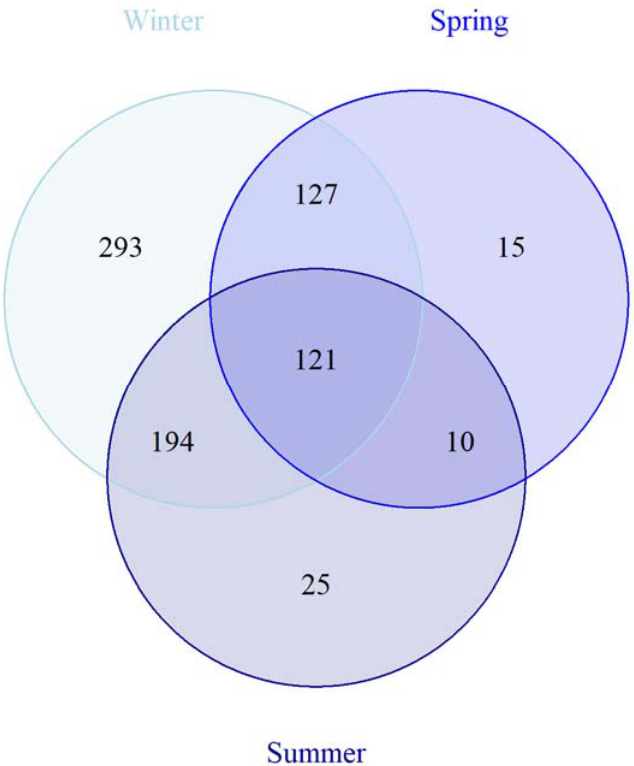
Figure 6. Venn diagram comparing the abundance of the different ASVs for each season (winter = light blue, spring = blue, and summer = dark blue). Each circle represents a season with the number of ASVs specific for the season stated inside. Overlapping areas show the occurrence of specific ASVs in two or all three seasons.